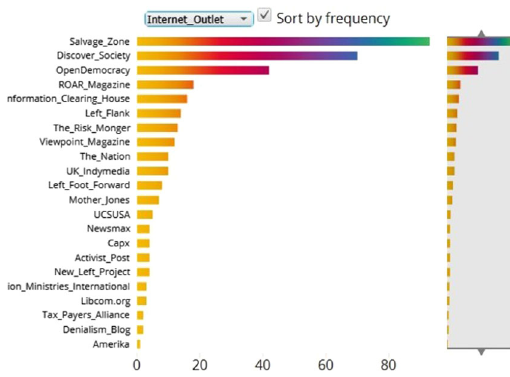
Fig. 3 Metafacet representation for - phobia and - phobic. Sorted by frequency per